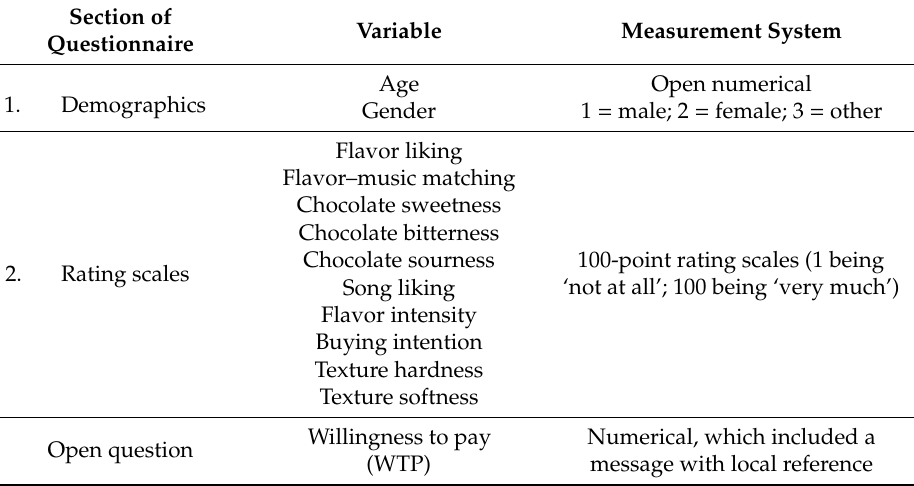
Table 1. Experimental design, including the variables that were sampled, and the measures used in order to assess each variable. Note that the presentation of variables was randomized.